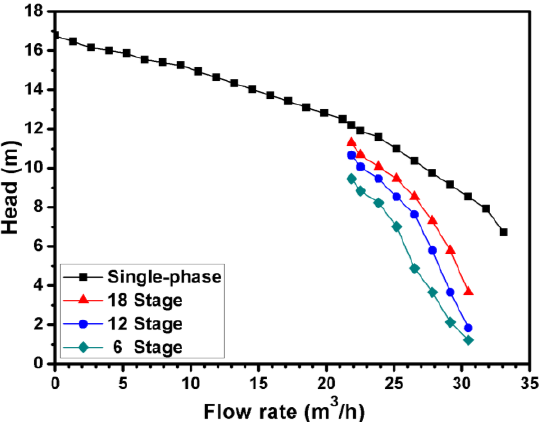
Figure 6. Performance curve for a mixed-flow pump with a different number of stages with best efficiency point (BEP) = 26.5 m 3 /h (4000 B/D) and free gas = 15% [34].